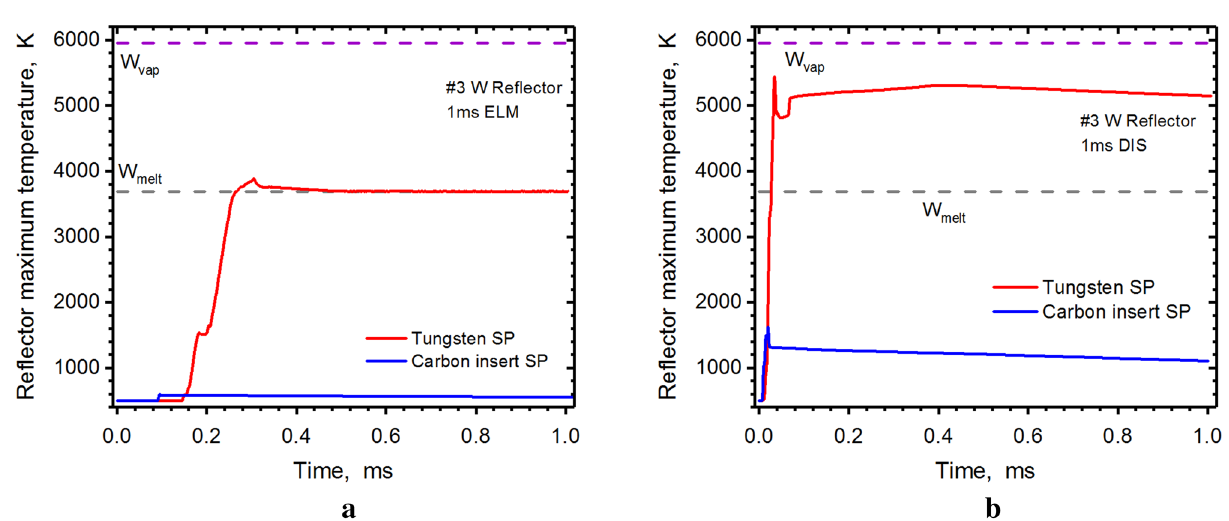
Figure 5. HEIGHTS simulation of PFC transient response: reflector maximum surface temperature during 1.0 ms ELM ( a ), 1.0 ms disruption ( b ), see Fig. 1b for surfaces location. Tungsten SP (red), carbon insert at SP (blue). The images were prepared using OriginPro